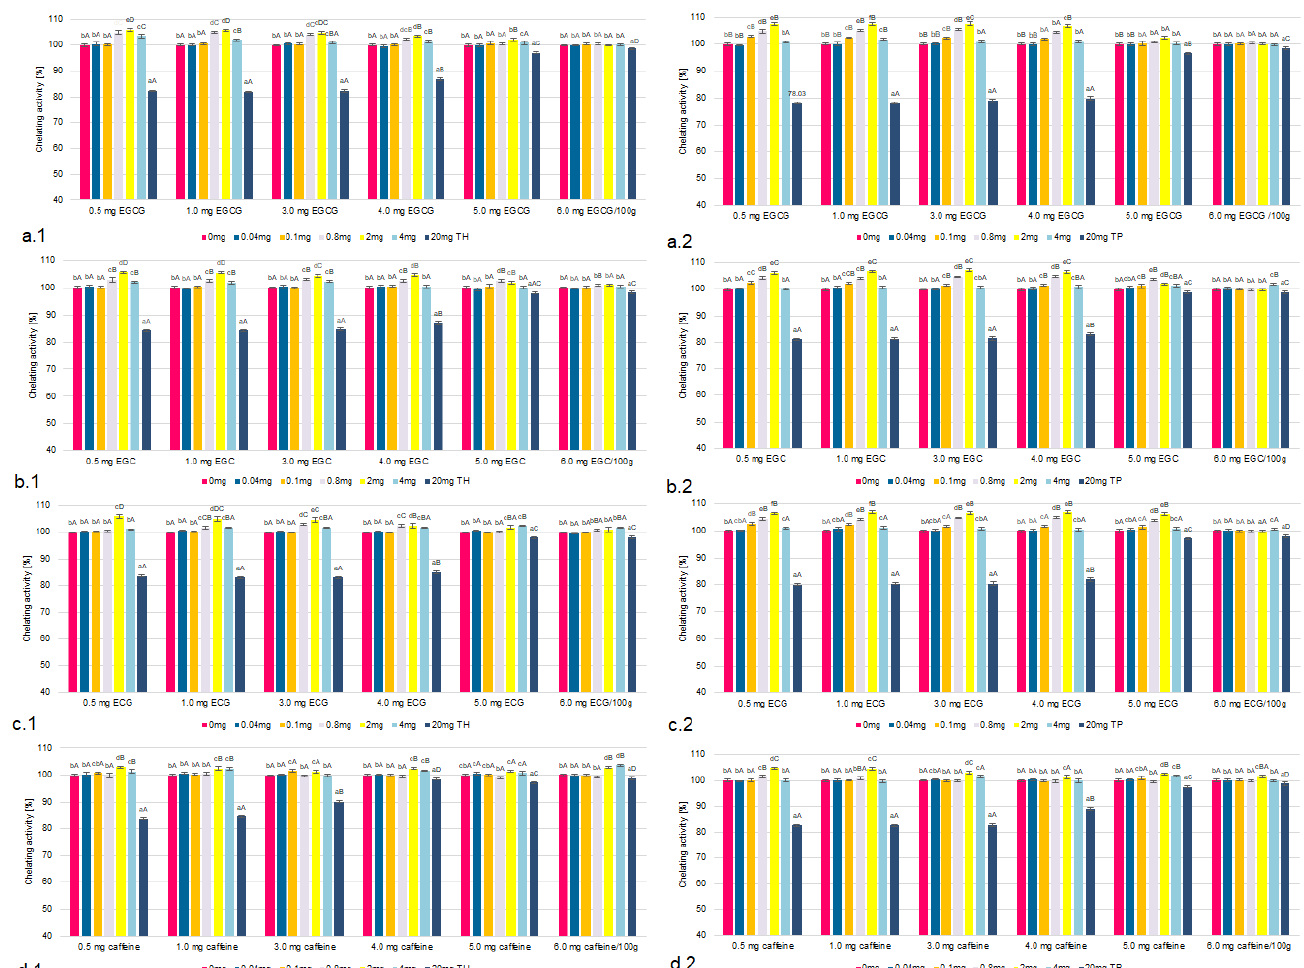
Figure 1. The chelating properties of EGCG ( a ), EGC ( b ), ECG ( c ) and caffeine ( d ) in the models with TH ( 1 ) and TP ( 2 ), compared to a sample without thiamine; different letters (lower letters in the same concentration of antioxidant; bold letters in the same concentration of thiamine denote a significant difference at p < 0.05 (one-way ANOVA, and post hoc Tukey test).